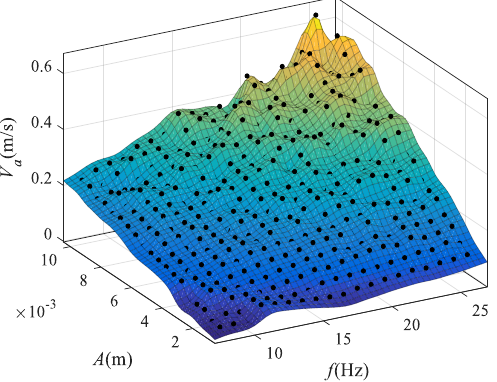
Figure 7. Average speed with A = 1 – 10 mm, f = 8 – 26 Hz, θ = 10°, and a = 90°.